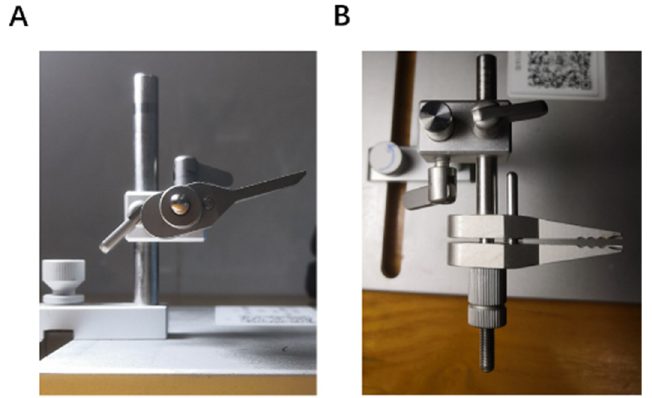
Figure A4. Equipment for ROM. ( A , B ) The injured hind-limb was harvested and fixed in a custom apparatus where the tibia was rigidly gripped to prevent rotation.